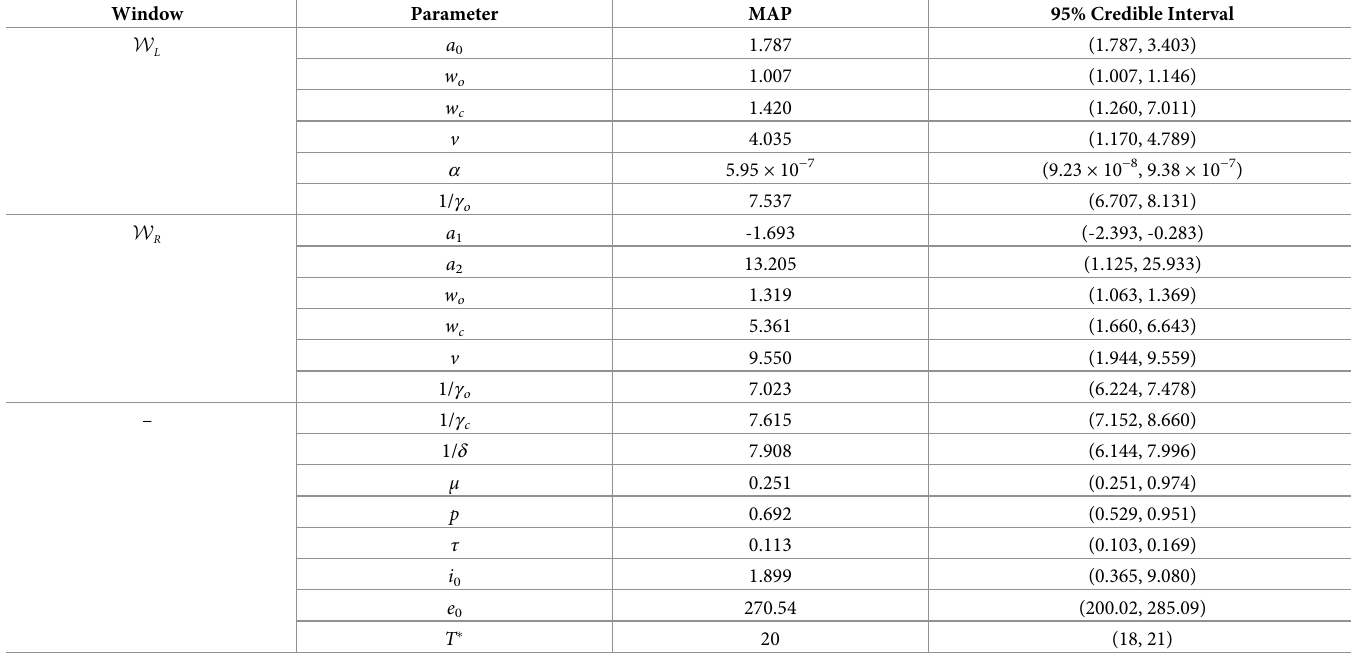
Table 5. Summary results for Malaysia (with redistributed cases).